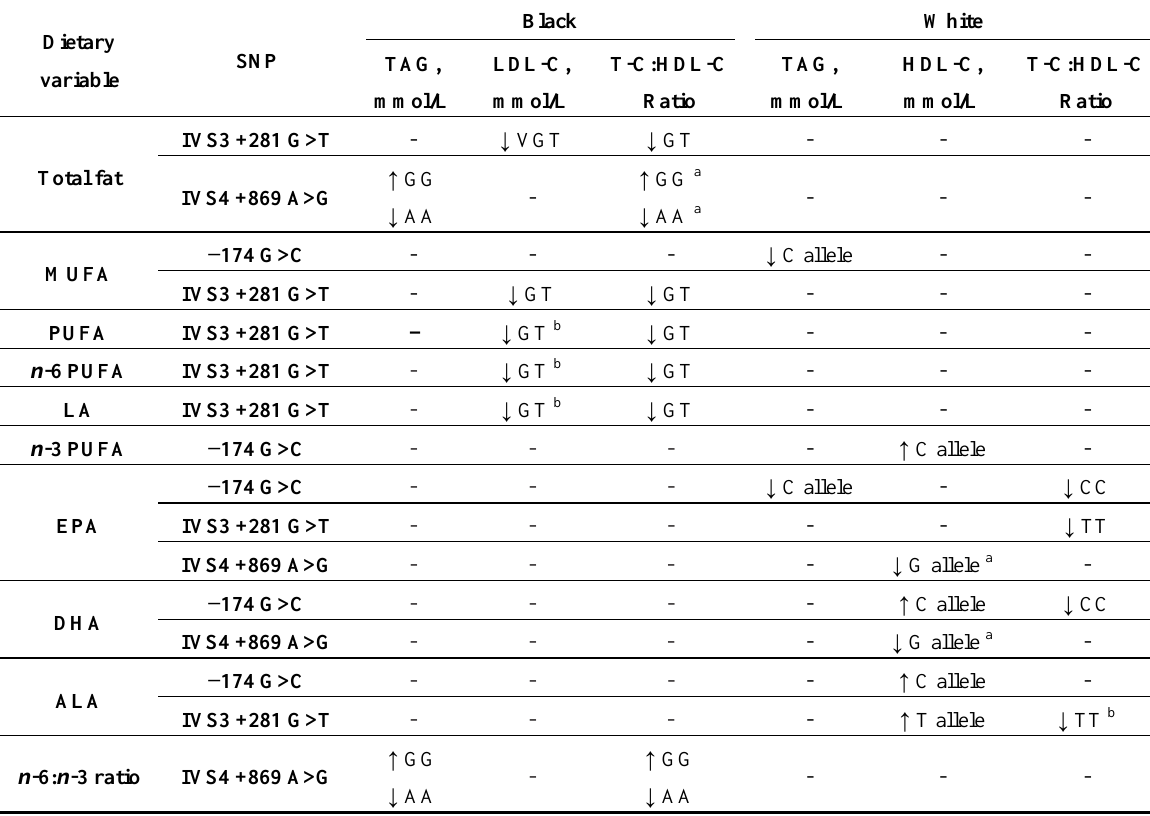
Table 5. Summary of IL-6 diet-gene interactions on serum